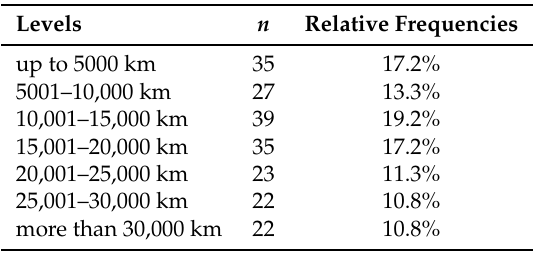
Table 2. Annual mileage of the